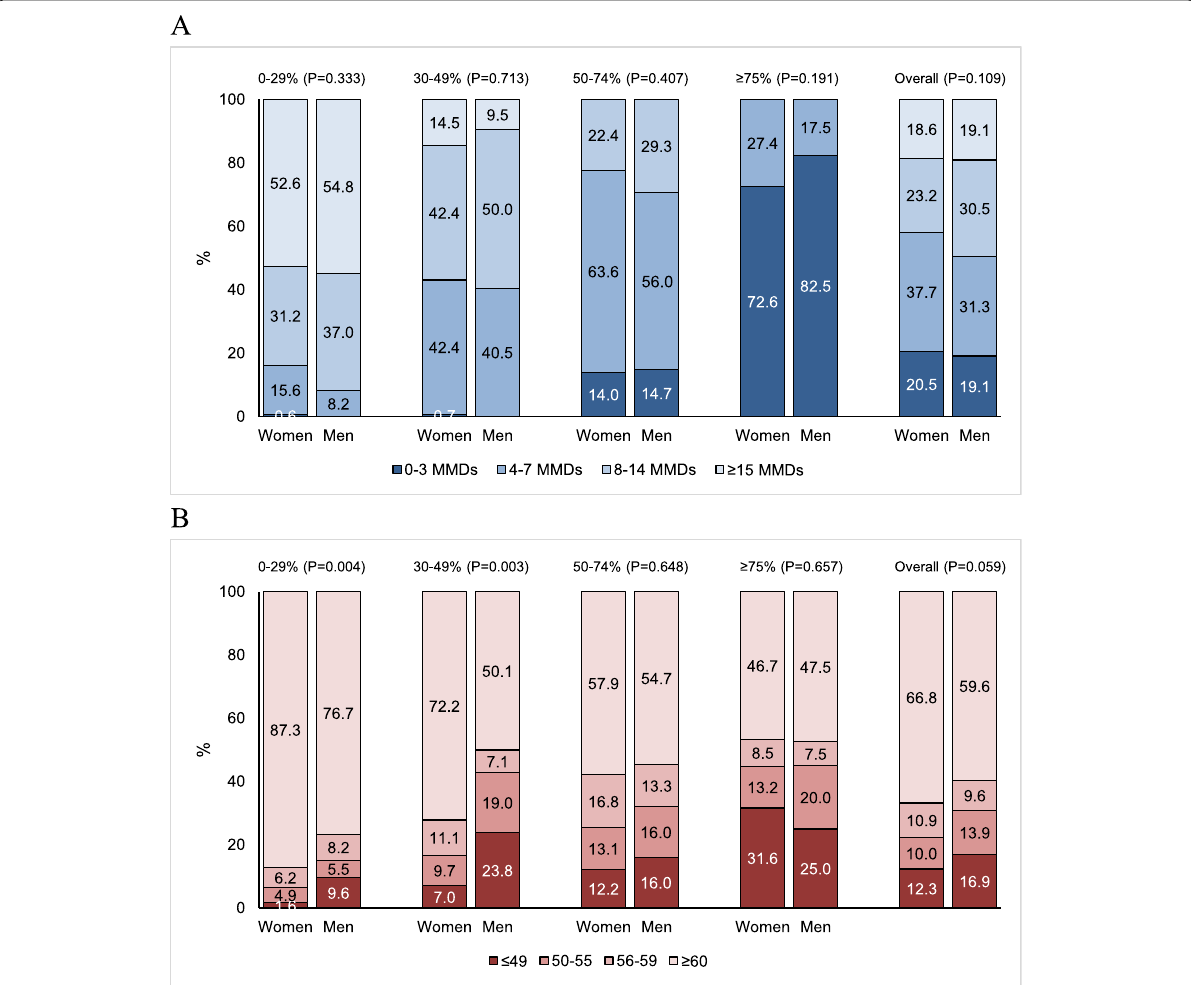
Fig. 4 Residual monthly migraine days ( A ) and Headache Impact Test-6 score ( B ) at weeks 9-12 according to erenumab response categories in men and